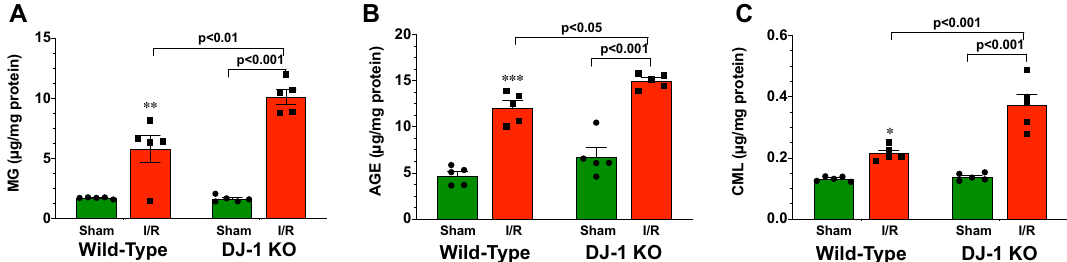
Figure 1. Deficiency of DJ-1 Enhances ischemia–reperfusion induced mitochondrial glycative stress. Levels of ( A ) methylglyoxal (MG), ( B ) advanced glycation end products (AGE), and ( C ) carboxymethyllysine (CML) in mitochondrial fractions. All measurements were performed in samples collected at 3 days of reperfusion from Wild-Type and DJ-1 KO mice. Values are means ± SEM. 5 samples per group. Two-way ANOVA with Tukey’s multiple comparisons test. * p < 0.05, ** p < 0.01, and *** p < 0.001 vs. Wild-Type